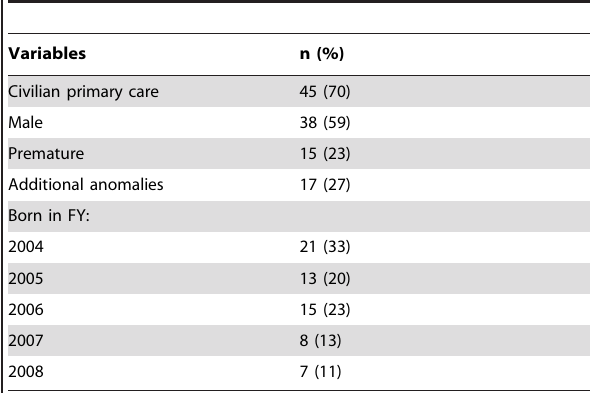
Table 1. Demographics and distribution by fiscal year (FY) of all 64 biliary atresia born in the military health system FY 2004–2008.